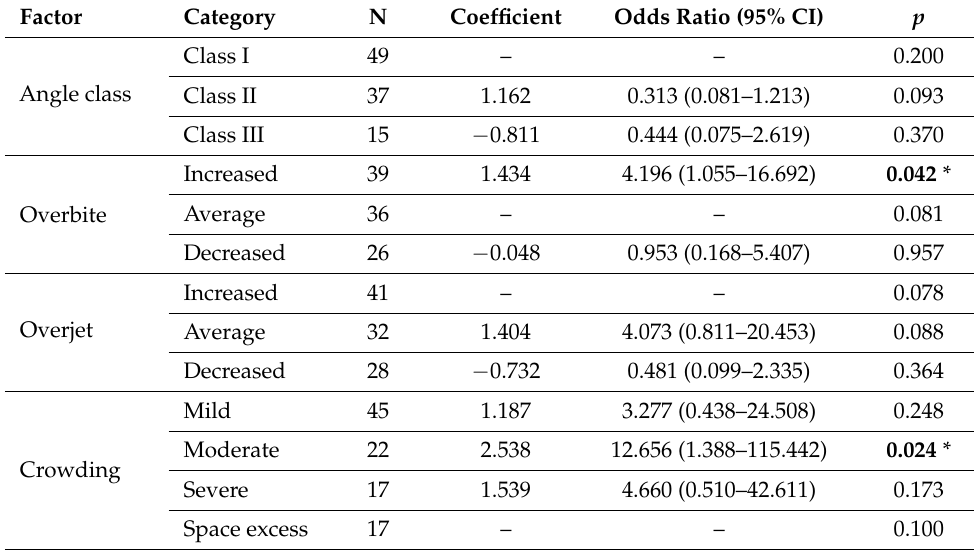
Table 5. Binary logistic regression analysis to detect risk factors of bracket